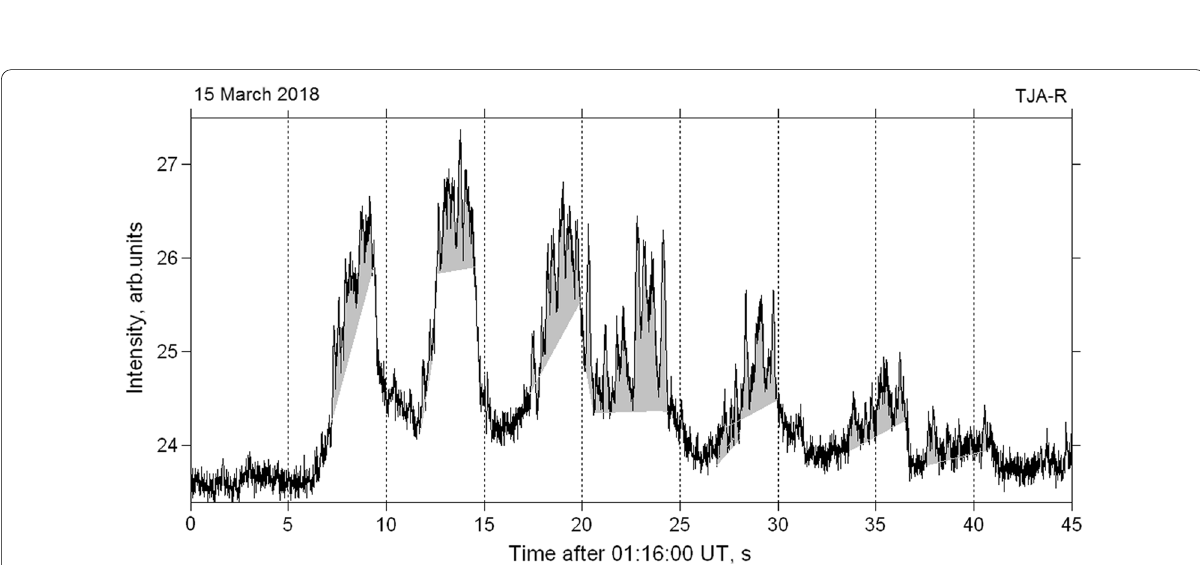
Fig. 8 Luminosity variation in the examined arc averaged over the square 10